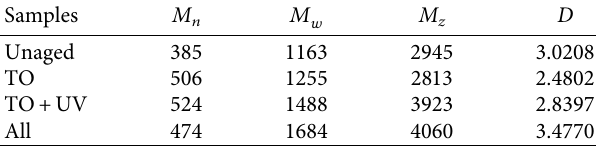
Table 1: The average molecular weight of asphalt binder samples. Samples